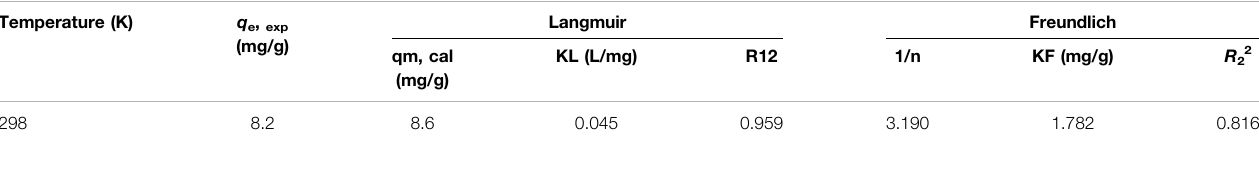
TABLE 3 | Parameters of Langmuir and Freundlich models.